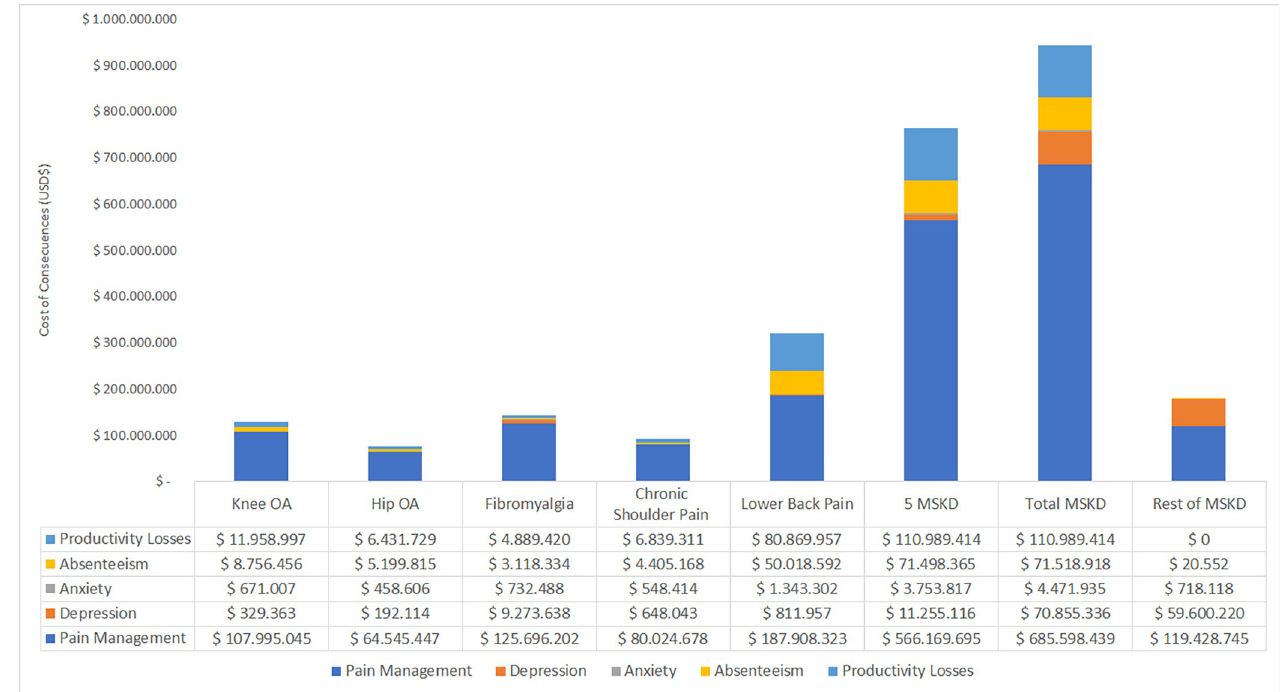
Fig 4. Graphical comparison of every outcome for each health problem, further total MSKD, the sum of health problems, and an estimation of the rest of MSKD.